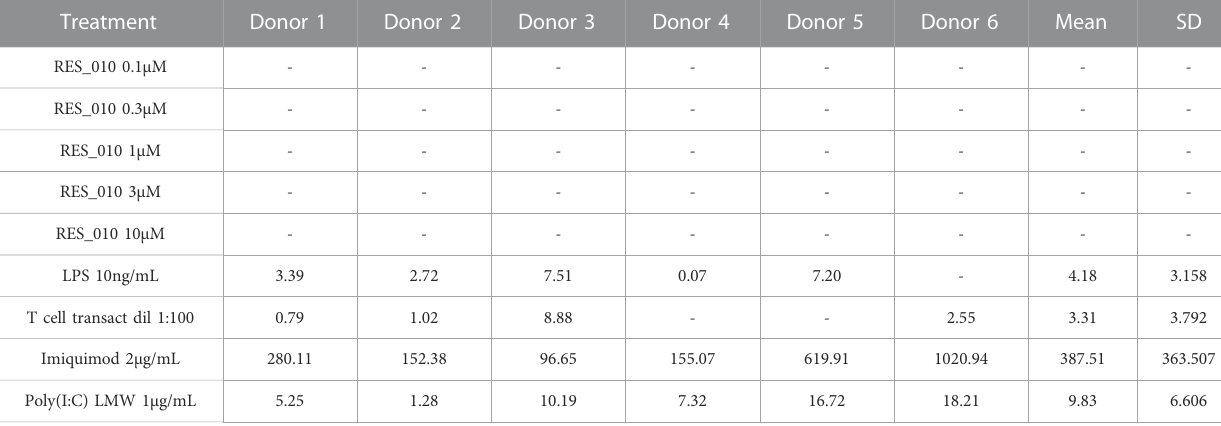
TABLE 1 Concentration Data Vehicle Corrected (pg/mL) for Cytokine IFN- α -2a. Treatment Donor 1 Donor 2